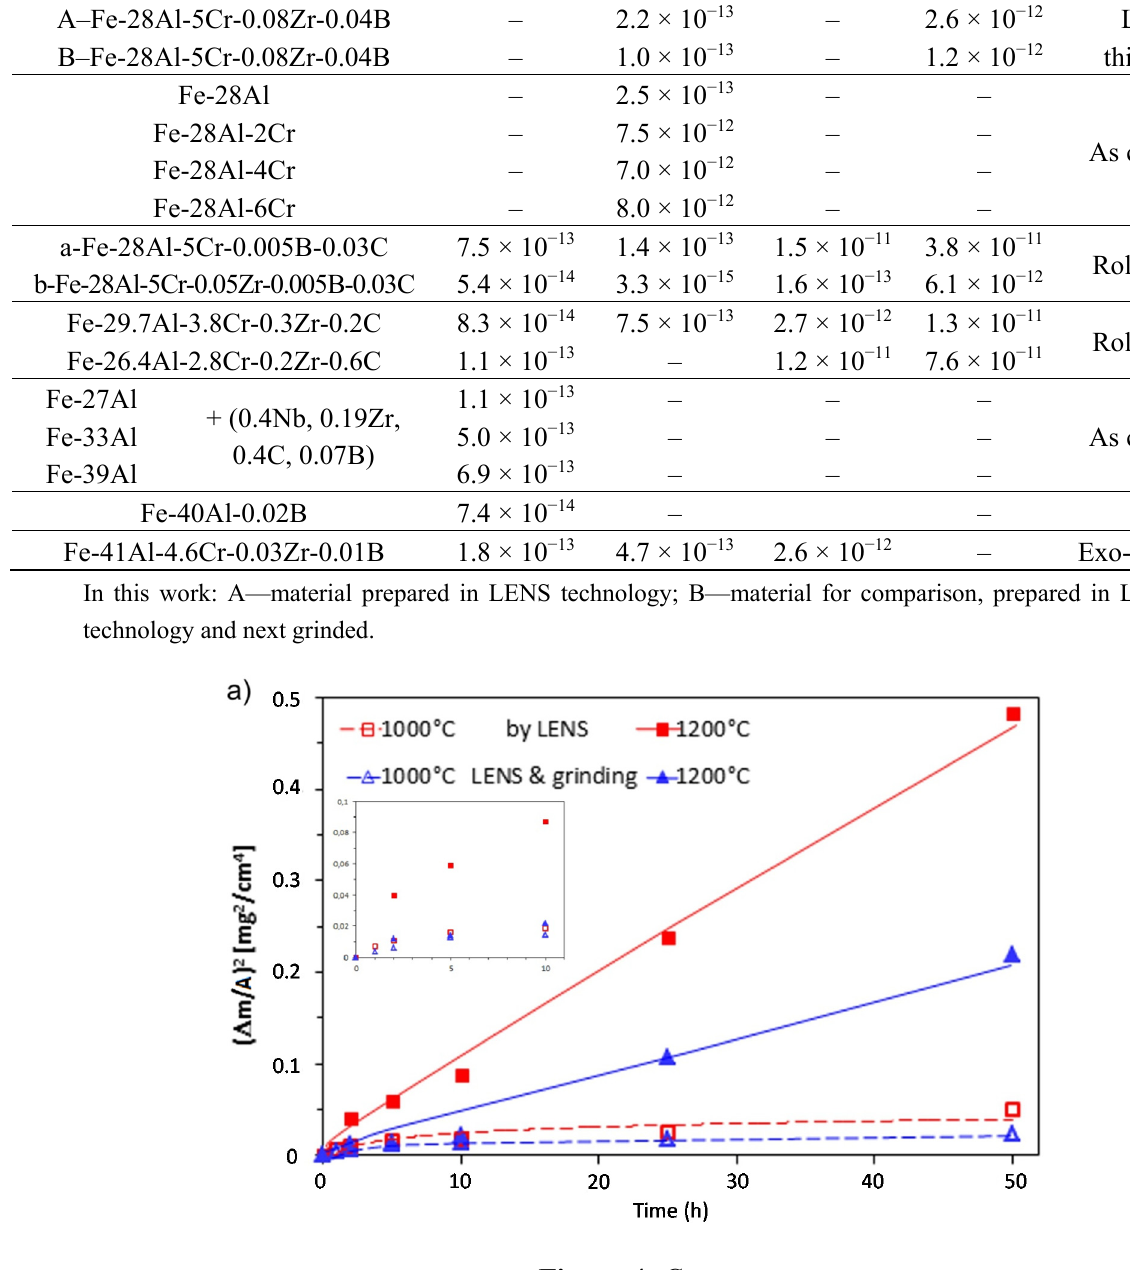
Table 1. Apparent parabolic rate constants k p of selected Fe-Al alloys oxidized in air. Alloy